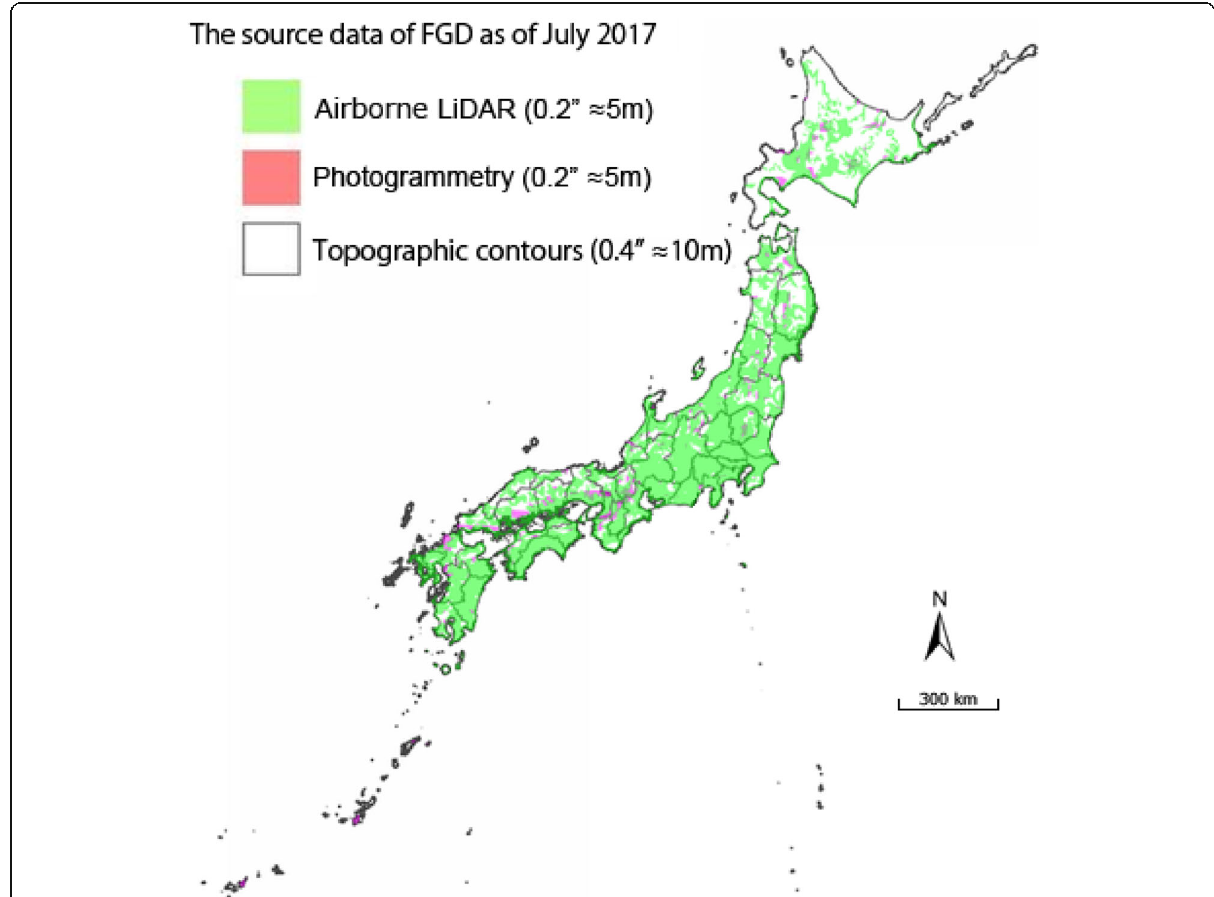
Fig. 6 Types of the source data of the DEM (FGD) used in this